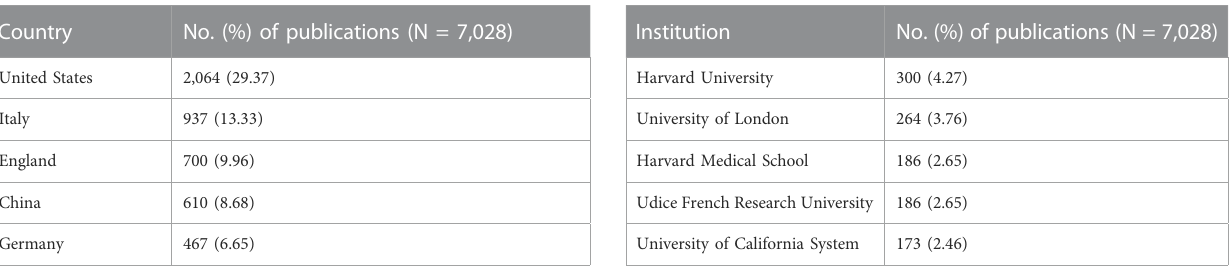
TABLE 4 The top fi ve